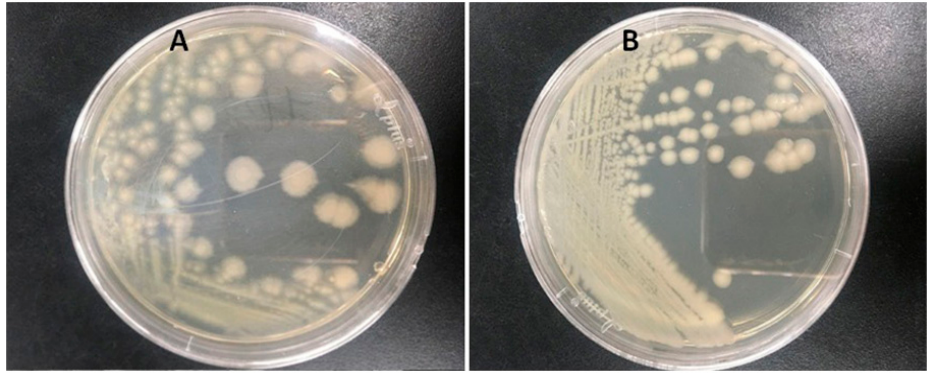
Figure 1. Bacterial colony photos of two atrazine-degrading bacteria. ( A : strain ATLJ-5, B : strain ATLJ-11).